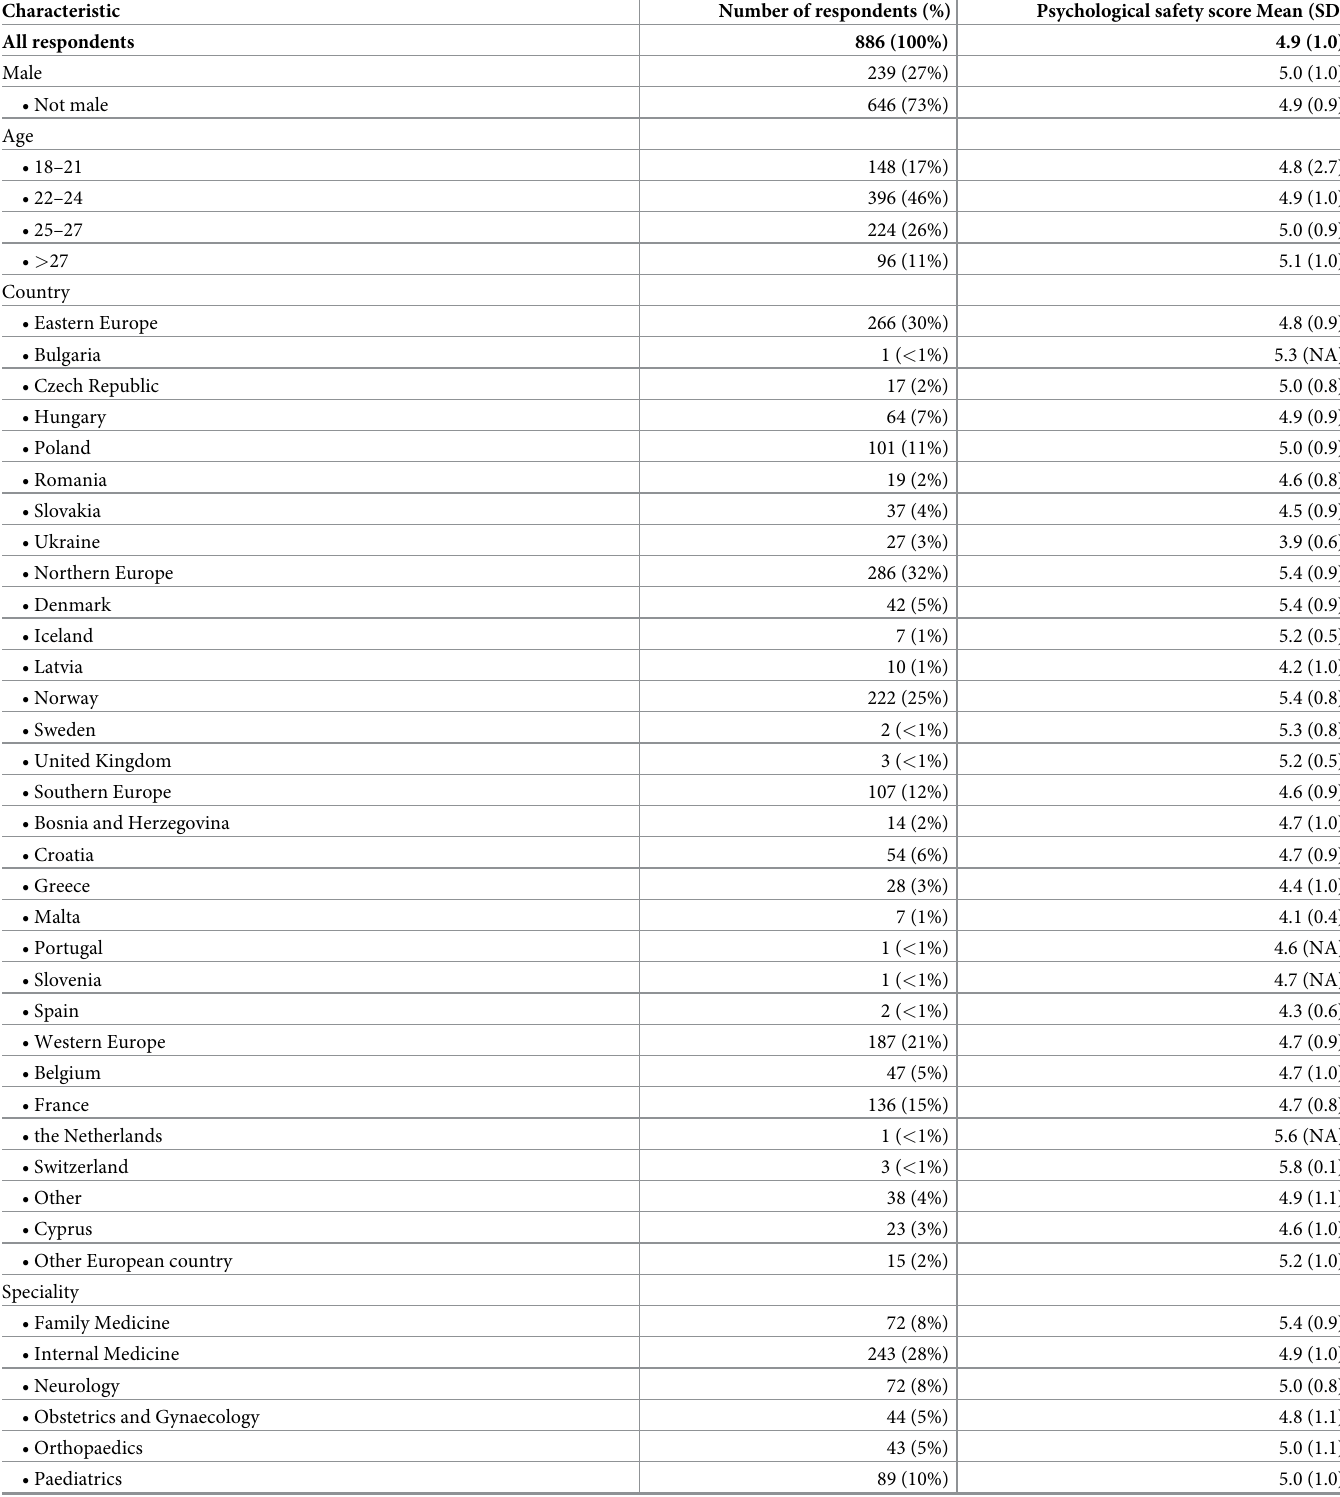
Table 1. Characteristics of the sample (N =